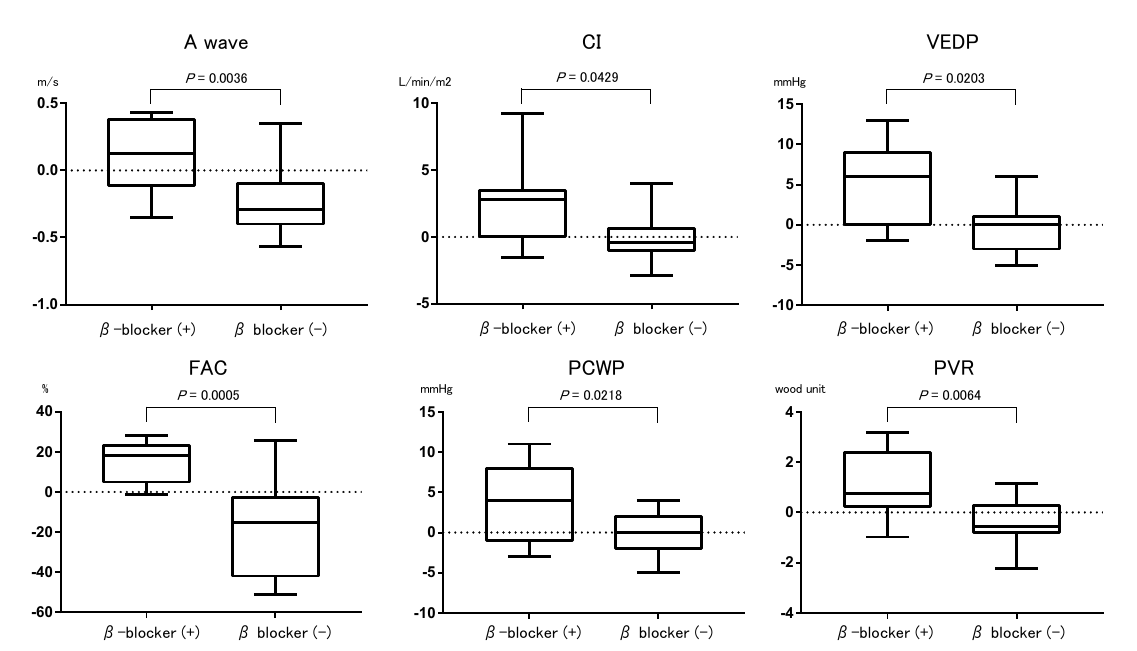
Figure 2. Amount of change in variables between baseline and follow-up data of patients with and without beta-blockers. The upper and lower borders of the box represent the upper and lower quartiles. The middle horizontal line represents the median. The upper and lower whiskers represent the maximum and minimum values of nonoutliers. CI, cardiac index; VEDP, ventricular end-diastolic pressure; FAC, fraction area change; PCWP, pulmonary capillary wedge pressure; PVR, pulmonary vascular resistance; β -blocker (+): beta-blocker group, β -blocker ( − ): non-beta-blocker group. Table 3. Amount of change in variables between baseline and follow-up data.